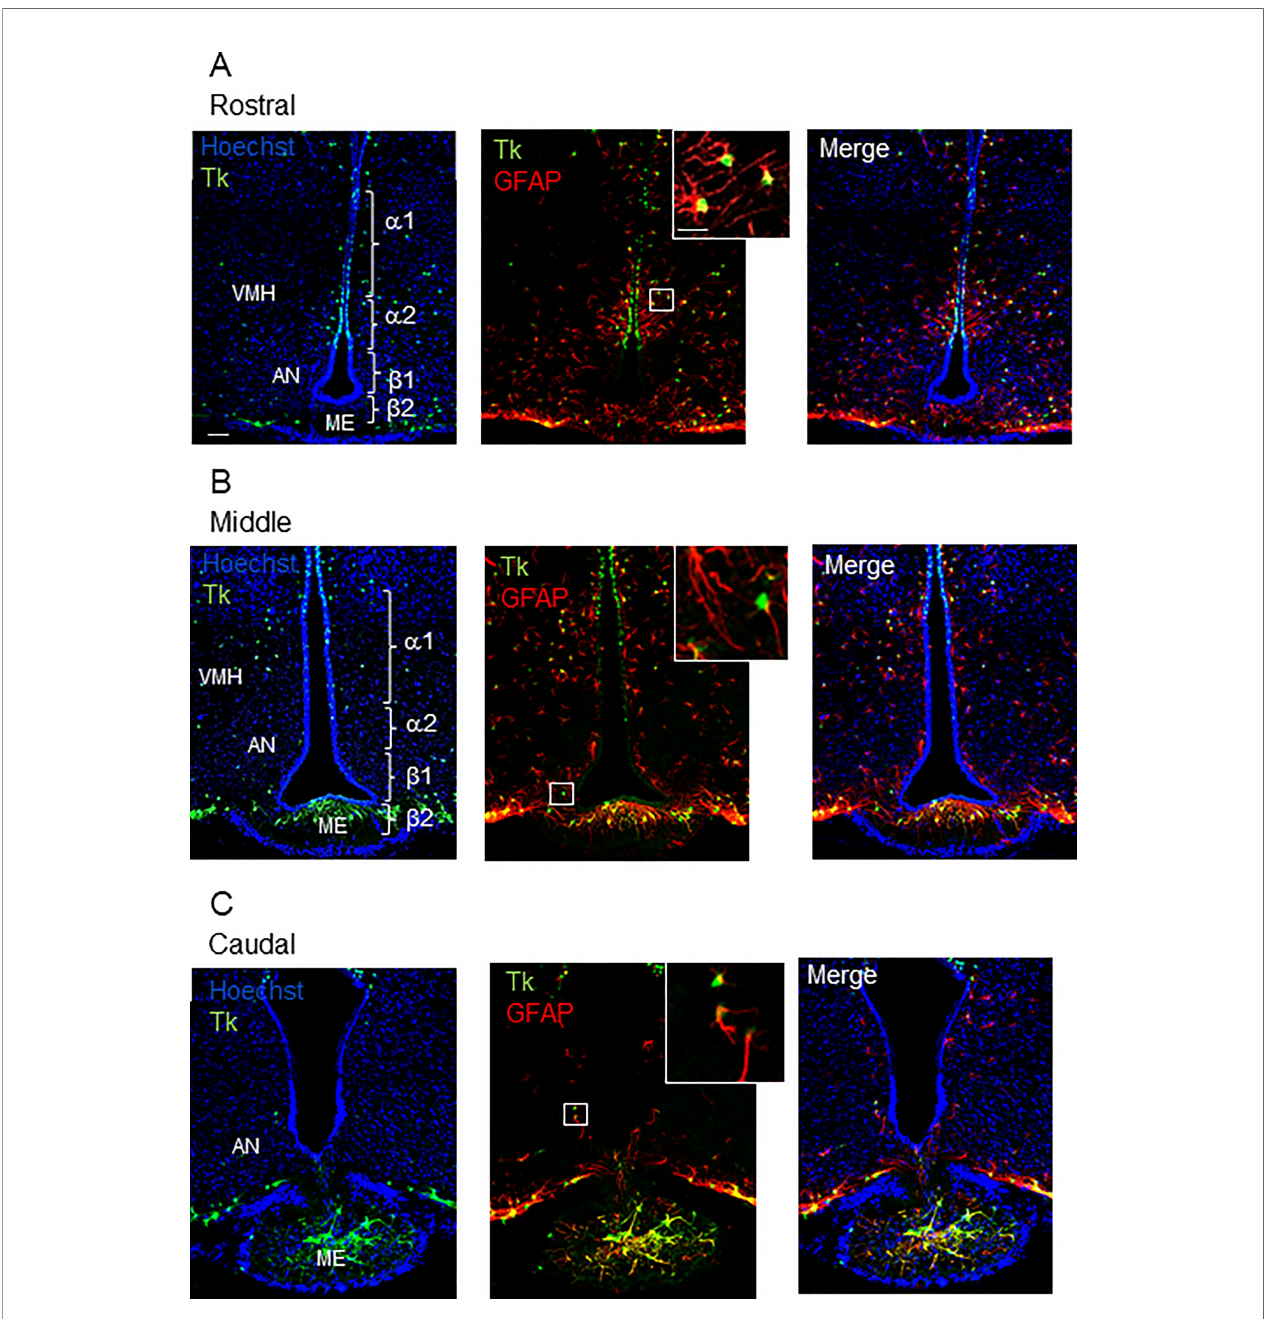
FIGURE 1 | Distribution of GFAP-positive/Tk-positive cells in the MBH of GFAP-Tk male mice. Rostral (A) , middle (B) and caudal (C) MBH showing for each panel, from left to right and up to down, confocal images of nuclei coloration with Hoechst (blue), Tk (green), GFAP (red), Hoechst/Tk, Hoechst/GFAP expression and the merge image. Insets are high magni fi cation showing Tk (green), and GFAP (red) immunopositive cells. All the Tk-positive cells are located in the ependymal layer of the VMH and the dorsal AN, corresponding to the localization of a 1 and a subset of a 2 tanycyte subtypes. GFAP-positive/Tk-positive cells are also detected in the AN and ME parenchyma. VMH, ventro-medial hypothalamus; AN, arcuate nucleus; ME, median eminence; Tk, thymidine kinase. Scale bars, 20 µm; Insets: 5